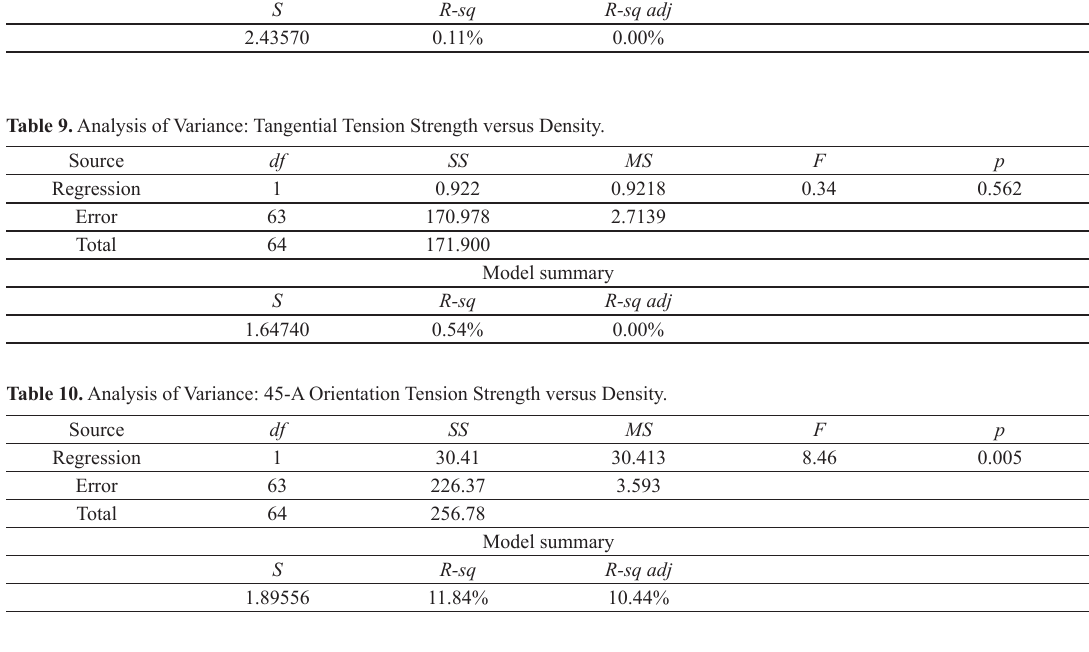
Table 11. Analysis of Variance: 45-B Orientation Tension Strength versus Density.